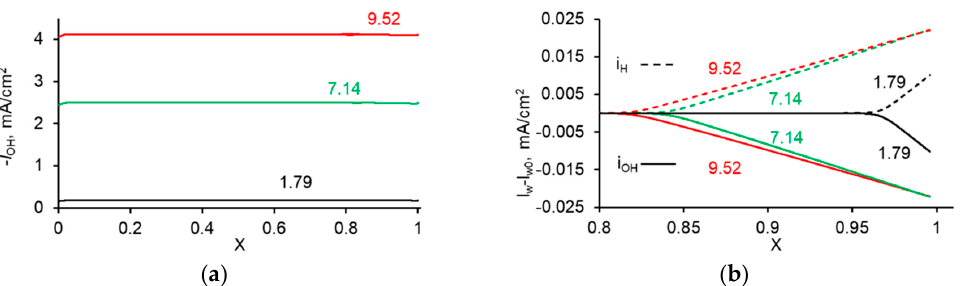
Figure 7. The partial current density of the OH − ions ( a ) and the increment, I w − I w0 , of the current densities of the H + and OH − ions, I w , over their values at x = 0, I w0 , as functions of the distance, x , in the depleted diffusion layer at the CEM ( b ) at different current densities; x = 0 relates to the bulk solution, x = 1, to the membrane surface. The values of the current density in mA cm − 2 are shown near the curves.